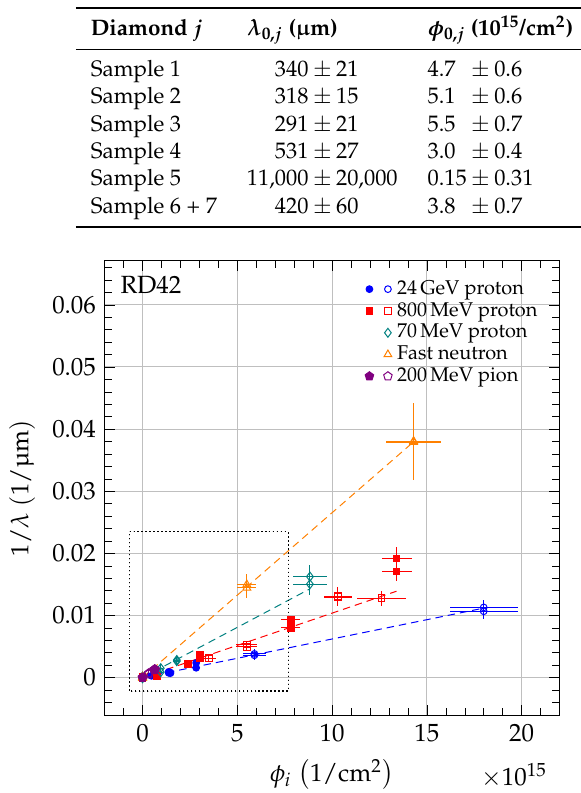
Figure 8. The 1/ λ for scCVD (solid markers) and pCVD (open markers) diamond. As reference, the 800MeV proton and 24GeV proton data from [4] are plotted. Each point is shifted by 1/ λ 0, j . The dotted box indicates the zoom area shown in Figure